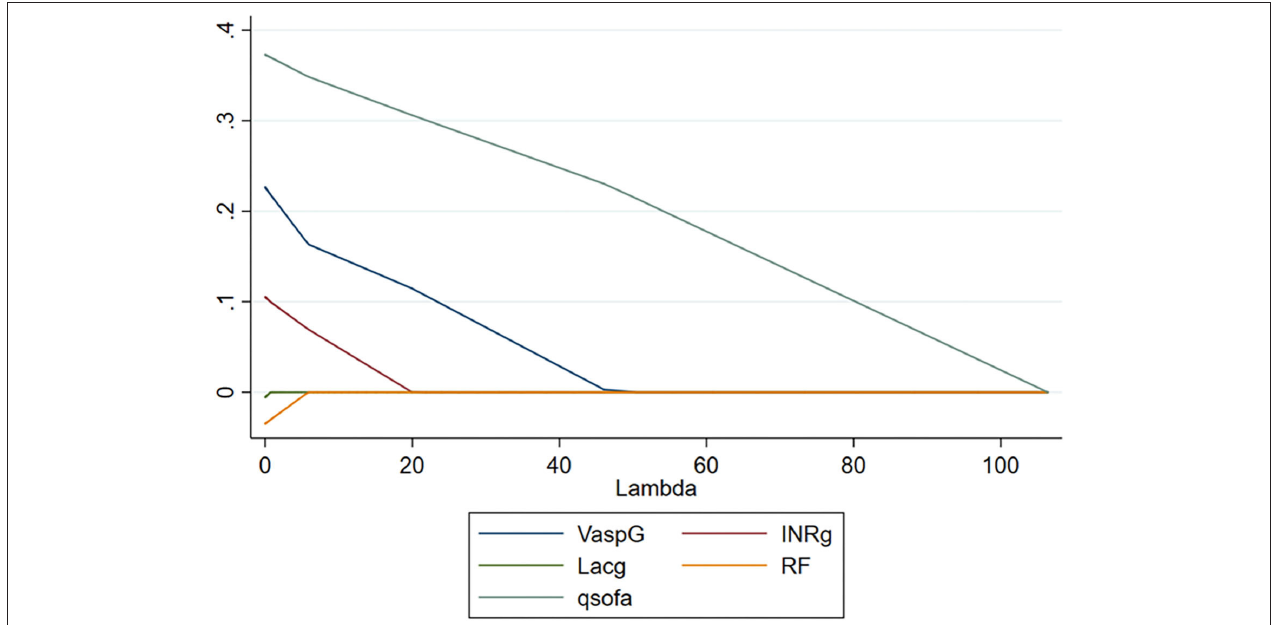
FIGURE 2 | LASSO regression analysis for hospital mortality in patients with Sepsis-3.0 who received CRRT. VaspG (blue line): use of vasopressor; INRg (purple line): INR > 1.5; Lacg (green line): lactate ≥ 4 µ mol/L; RF (orange line): severity of impaired pulmonary function (defined as PaO 2 /FiO 2 (PF) > 300 mmHg, 200 mmHg < PF ≤